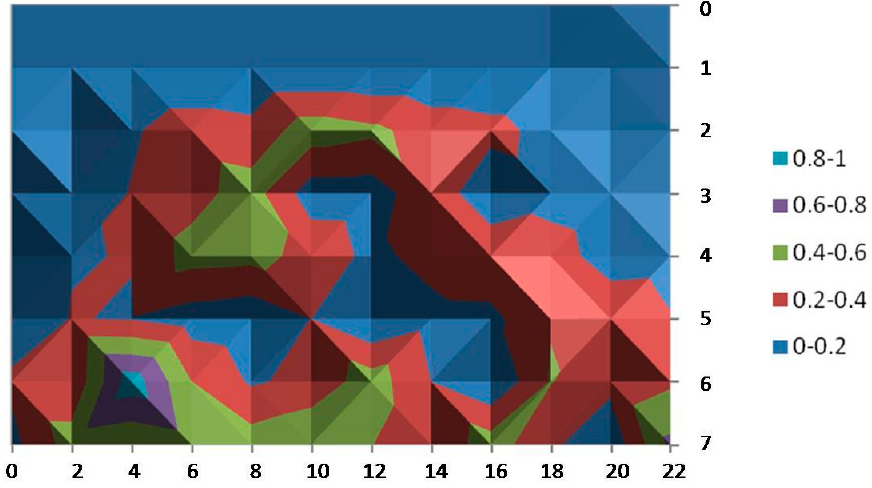
Figure 8. Average error for the y-coordinate.